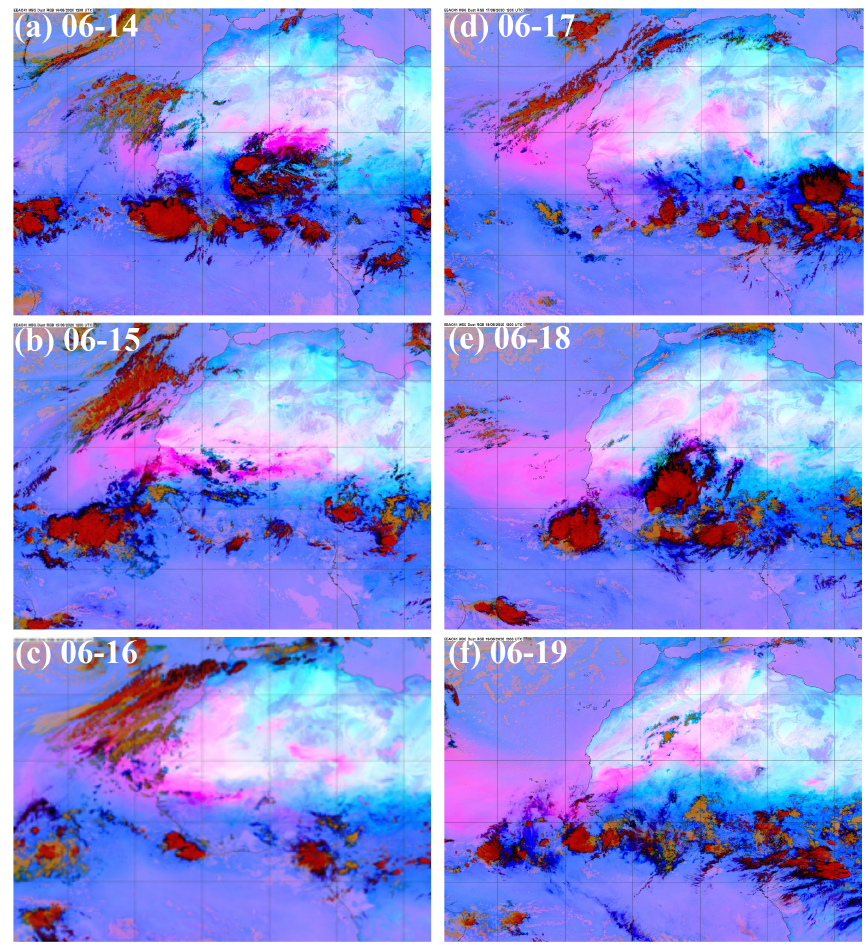
Figure 11. Coastal accumulation and ventilation of dust plumes (magenta) from haboobs (associated with mesoscale convection systems, dark red) and other meteorological processes in West Africa as revealed by SEVIRI RGB dust images at 12:00Z of (a) 06–14, (b) 06–15, (c) 06–16, (d) 06–17, (e) 06–18, and (f) 06–19. An animation of the SEVIRI images every 30min covering 12–25 June (https://doi.org/10. 5446/51548) clearly shows the evolution of haboobs and their radial outflow behavior, driven by outflows from convective